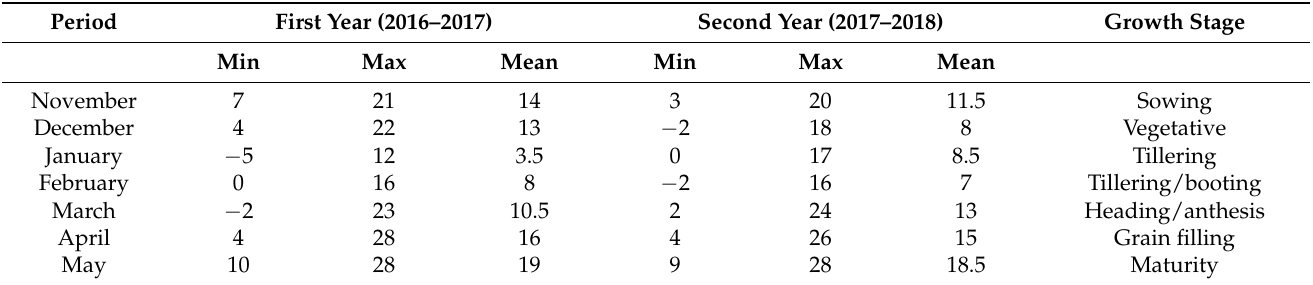
Table 1. Minimum, maximum and mean temperatures ( ◦ C) for 2016–2017 and 2017–2018 at the National Agricultural Research Centre,